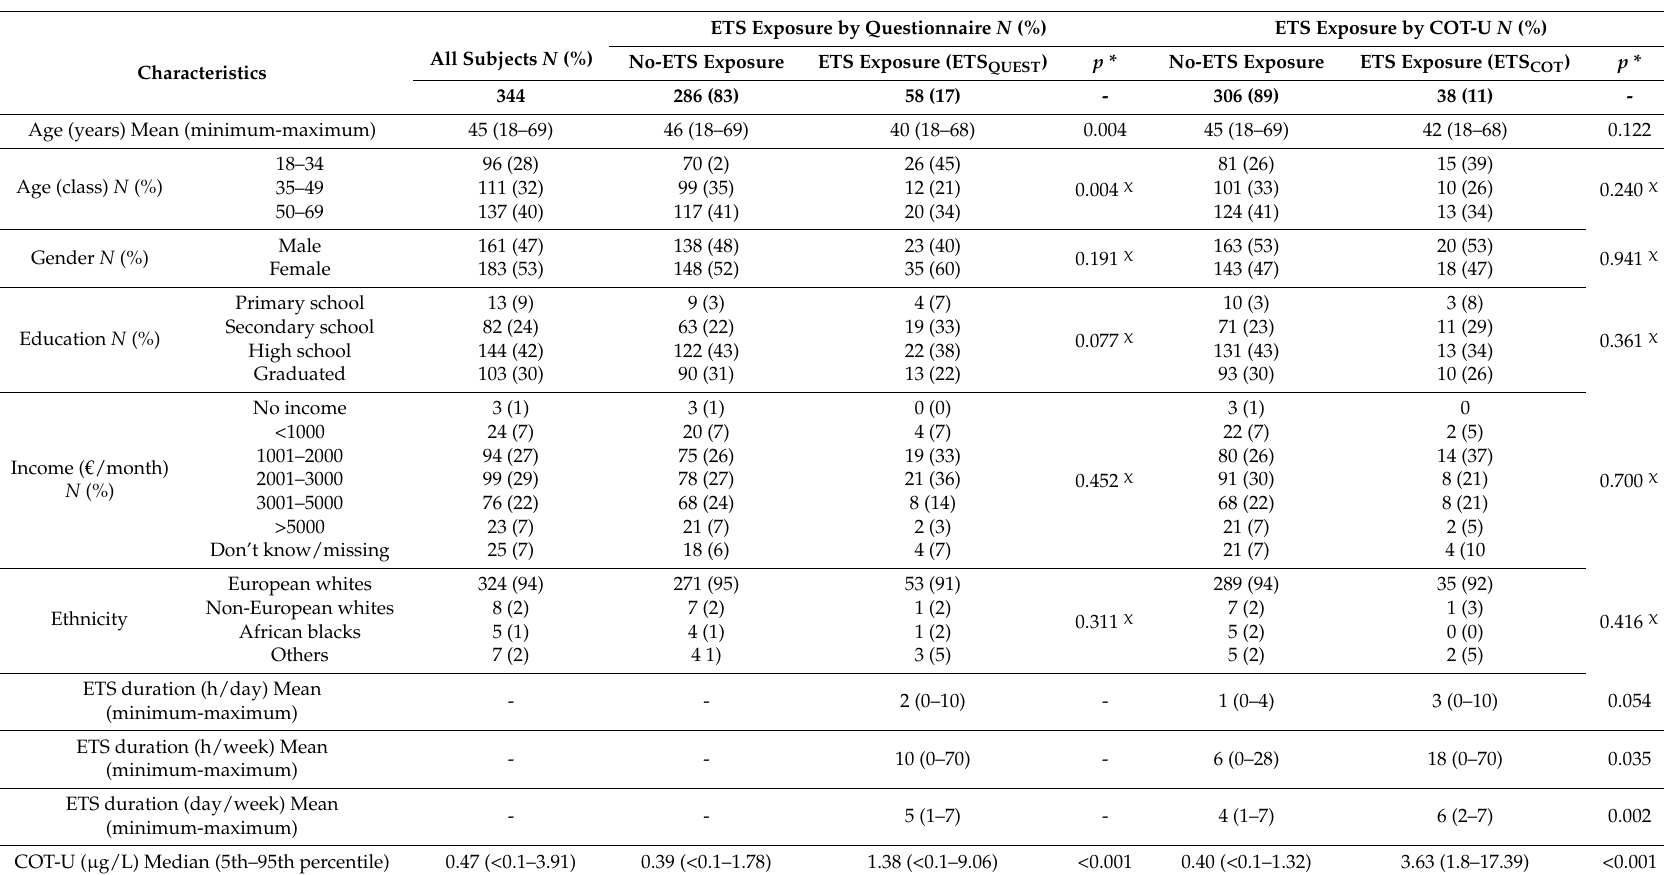
Table 1. Characteristics of participants ( n = 344), stratified by environmental tobacco smoke (ETS) exposure based on COT-U excretion (ETS COT : COT-U > 1.78 µ g/L = ETS exposed) and on self-classification by questionnaire (ETS QUEST